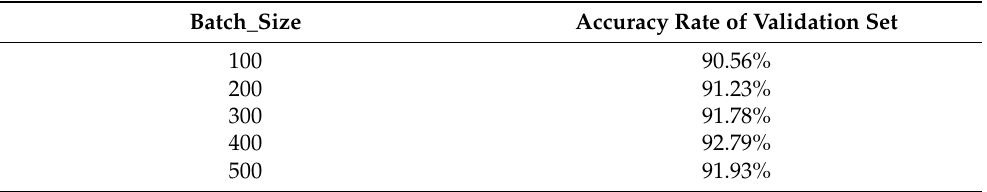
Table 1. SVM training results of different batches for the State pattern classifier.